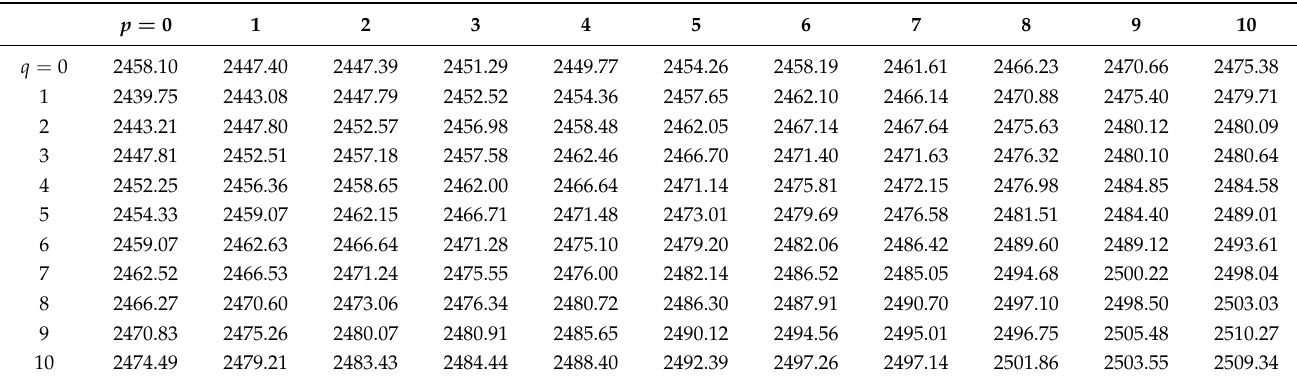
Table 2. The BIC values of the fitted ARMA ( p , q ) models of V T for p and q = 0,1, . . .